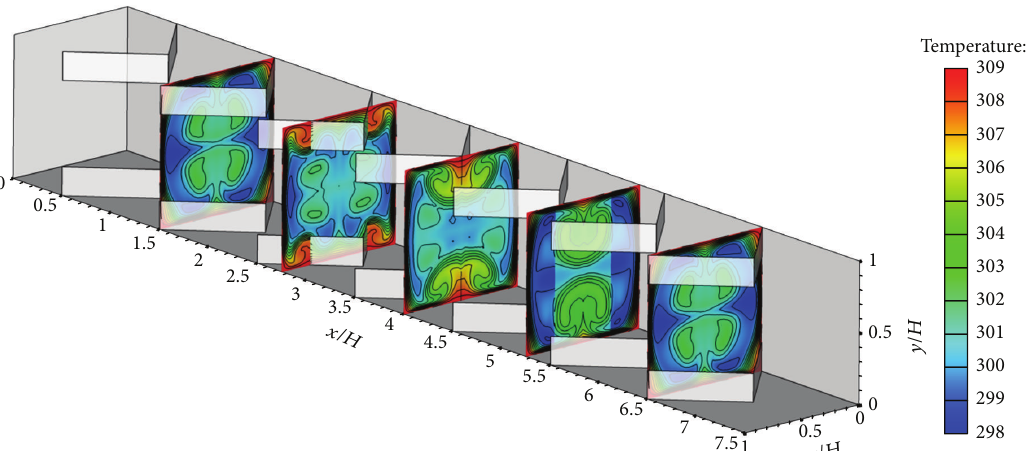
Figure 7: Contour plot of temperature in transverse plane for 𝛼 = 45 ∘ of V-Downstream rib at Re = 800 , BR = 0.20 , and PR = 1